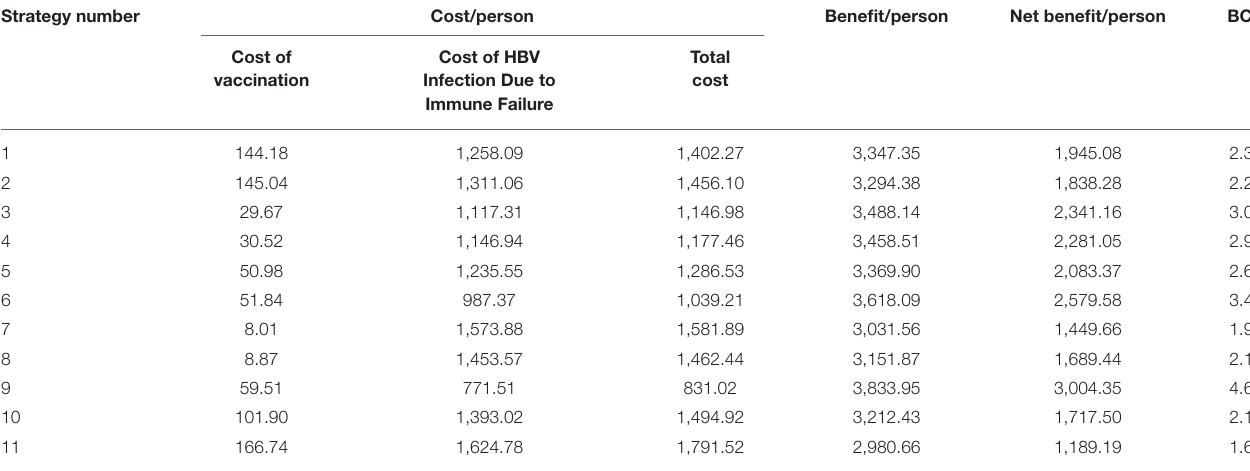
TABLE 6 | Cost-benefit analysis for vaccination strategies to prevent MTCT of the hepatitis B in China (in USD). Strategy number